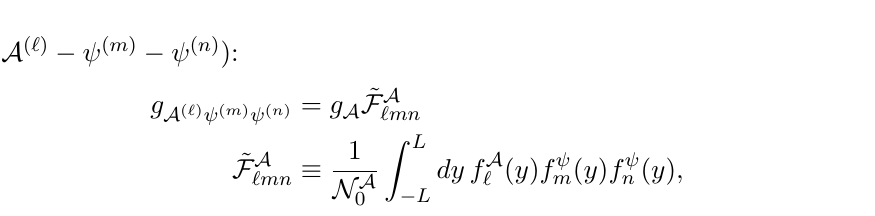
Figure 2 . Left: contours of constant level 2 gauge boson masses for R (cid:0) 1 = 1 TeV. The red contours show the mass of the lighter eigenstate A (2) and the blue contour represents mass of 1 heavier eigenstate A (2) . Right: the level 2 KK Weinberg angle sin 2 (cid:18) (2) for R (cid:0) 1 = 1 TeV and 2 W r B =L = 0 :